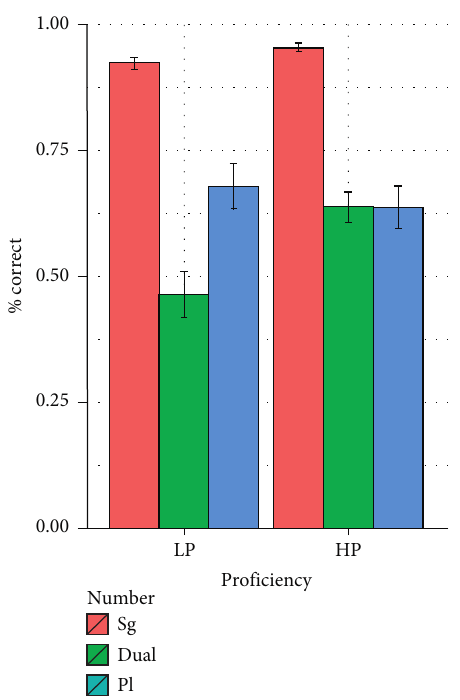
Figure 3: Mean % accuracy of adjective inflection on the pro- duction task, by proficiency and number across proficiency